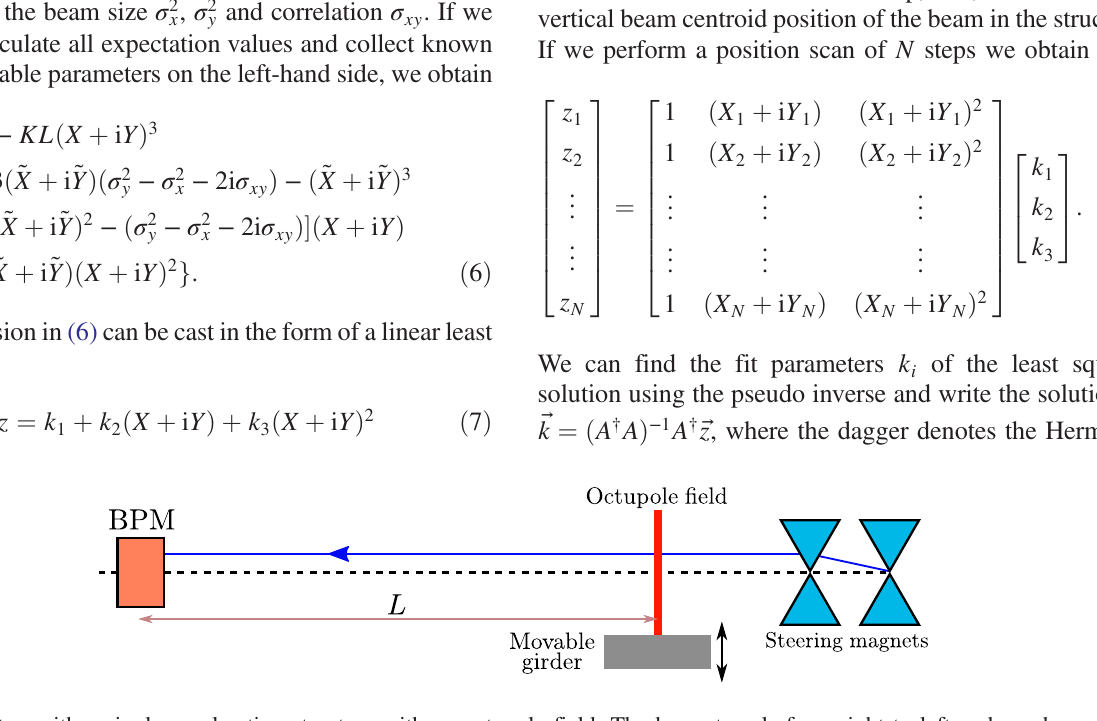
FIG. 1. Setup with a single accelerating structure with an octupole field. The beam travels from right to left and can be scanned transversely and parallel to the beam axis by moving the girder or by using two upstream steering magnets. The beam position shifts can be measured at a distance L downstream from the octupole with a beam position monitor